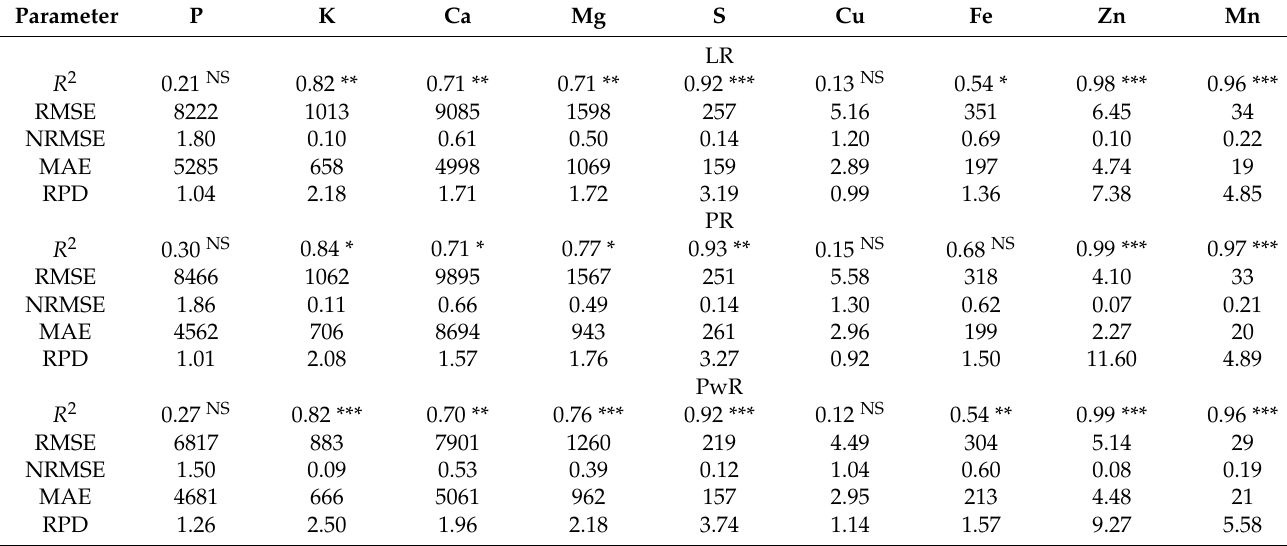
Table 4. Evaluation of the regression models through the dataset for predicting nutrient contents in the plant samples. Results are from the ‘modeling’